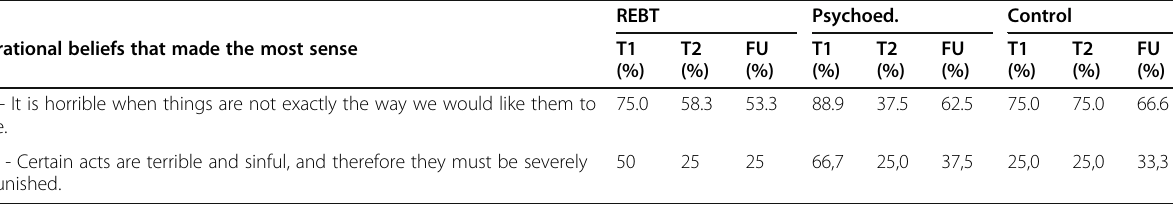
Table 2 Frequency by irrational beliefs Irrational beliefs that made the most sense